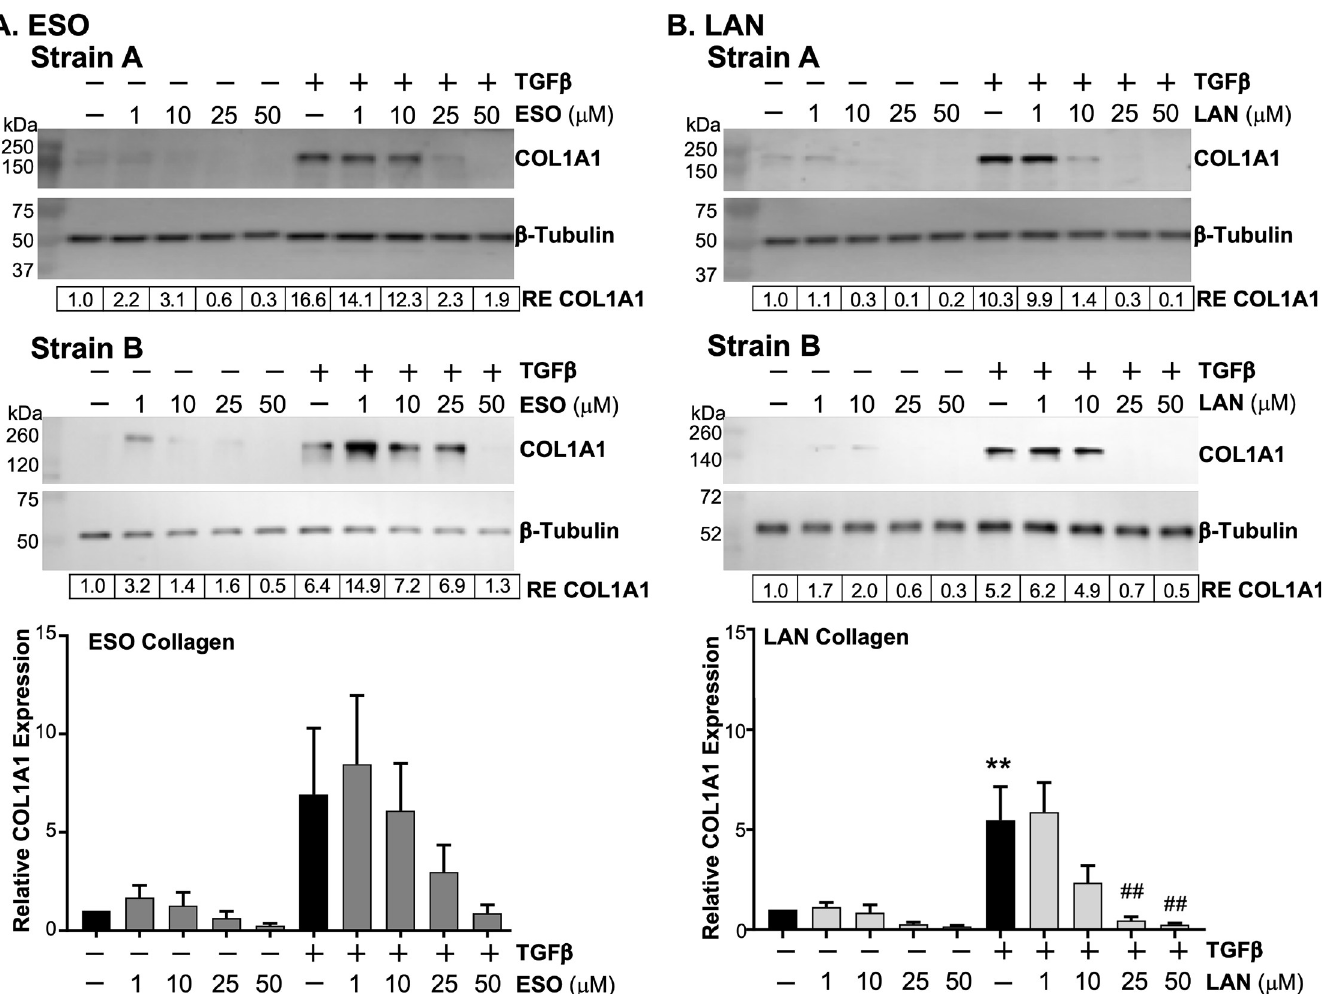
Fig 4. PPIs attenuate cell associated collagen induced by TGF β . PPIs were added to TED orbital fibroblasts 24h before 1ng/mL TGF β and then every 24h for the next 72h. Cell lysates were collected and measured for collagen 1A1 using Western blotting. Western blots from two representative TED orbital fibroblast strains are shown. A) Orbital fibroblasts treated with esomeprazole (ESO). B) Orbital fibroblasts treated with lansoprazole (LAN). RE = relative expression of protein bands compared with first band on the left. Bar graphs of the mean relative expression for each band depict a dose-dependent reduction in both basal and TGF-induced collagen levels and are shown beneath the Western blots. N = 4 different TED orbital fibroblast strains. �� = p < 0.01; significantly different from vehicle treated control. ## = p < 0.01; significantly different from TGF β alone. Statistics were measured by one-way ANOVA and Tukey’s post hoc